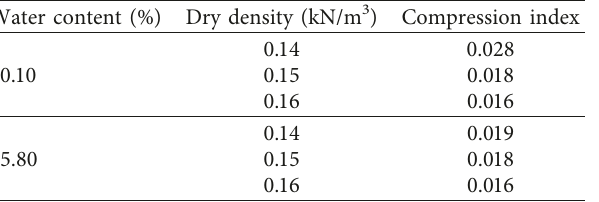
Figure 14: Relation between axial pressure and void ratio for different initial water contents. (a) Initial water content of 10.10%. (b) Initial water content of 15.8%. Table 3: Compression index of the samples.